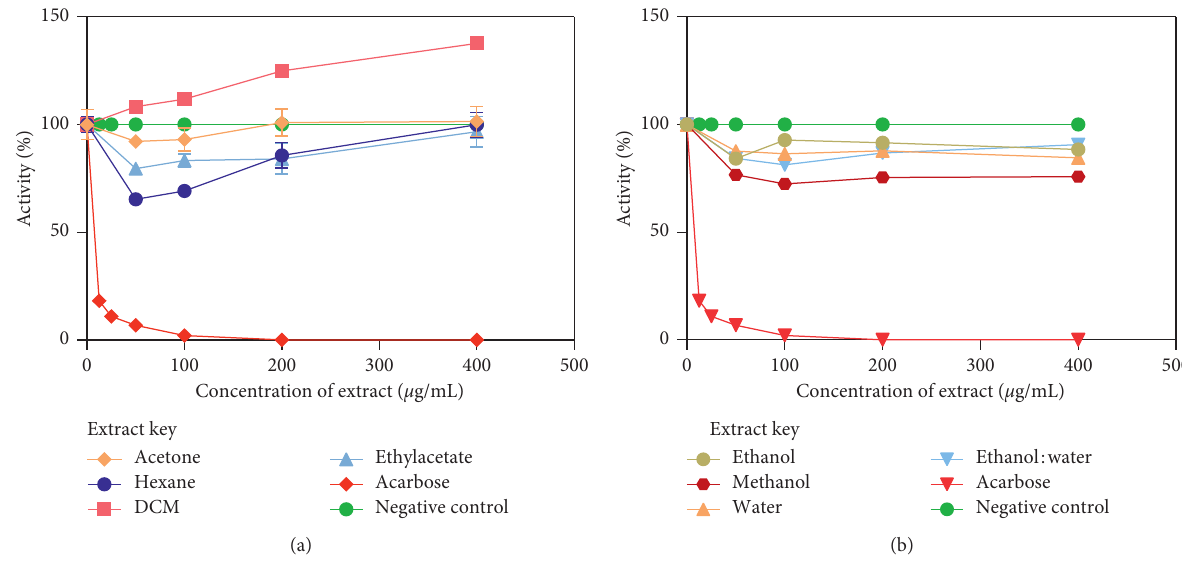
Figure 3: The effects of extracts of intermediate polarity and non-polar extracts (a) and polar extracts (b) from P. americana on the activity on α